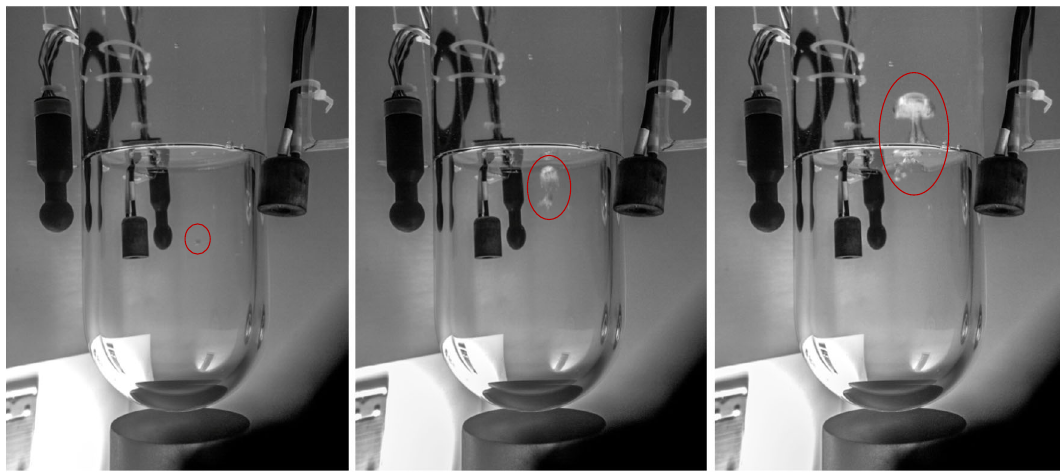
Fig. 7 A typical bubble nucleation and geyser formation occurred during a run at (cid:2) T = 8 . 47 ◦